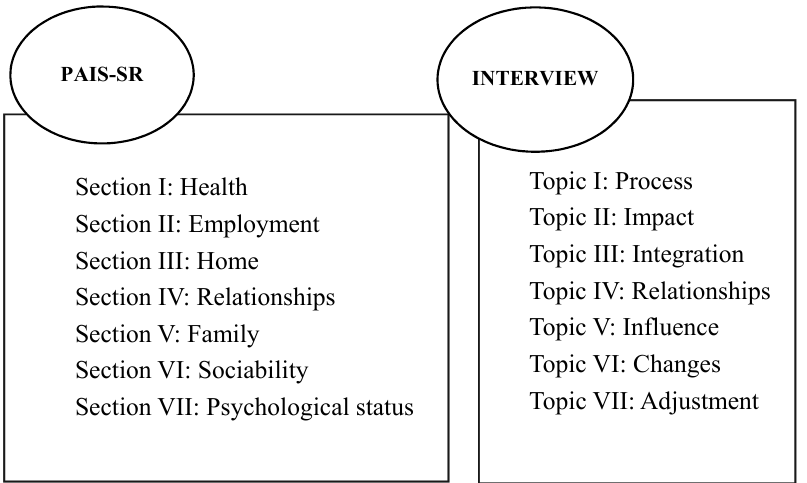
Figure 2. Equivalence of the contents of the PAIS-SR and the semi-structured interview. Source: own elaboration based on Portillo et al. [60].